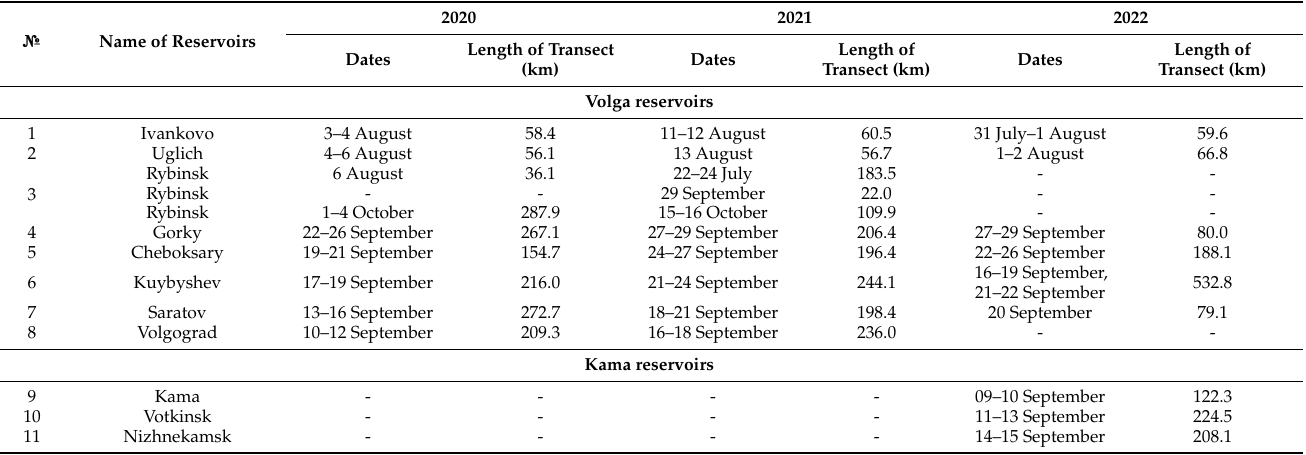
Table 2. Dates and length of transects in the fairway of the Volga–Kama reservoirs